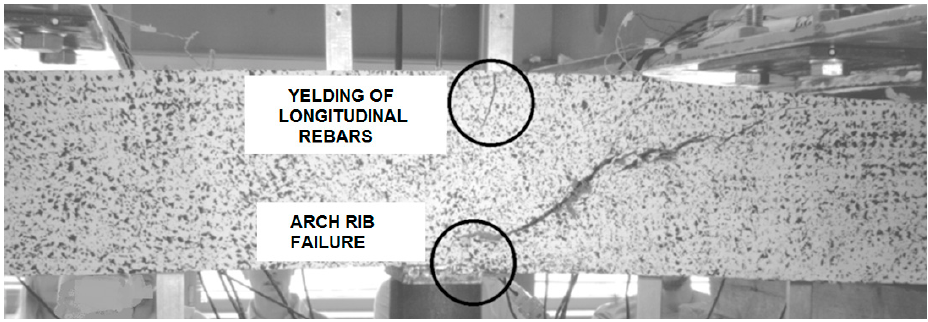
Figure 18. Typical secondary failure of a BFSa series beam.